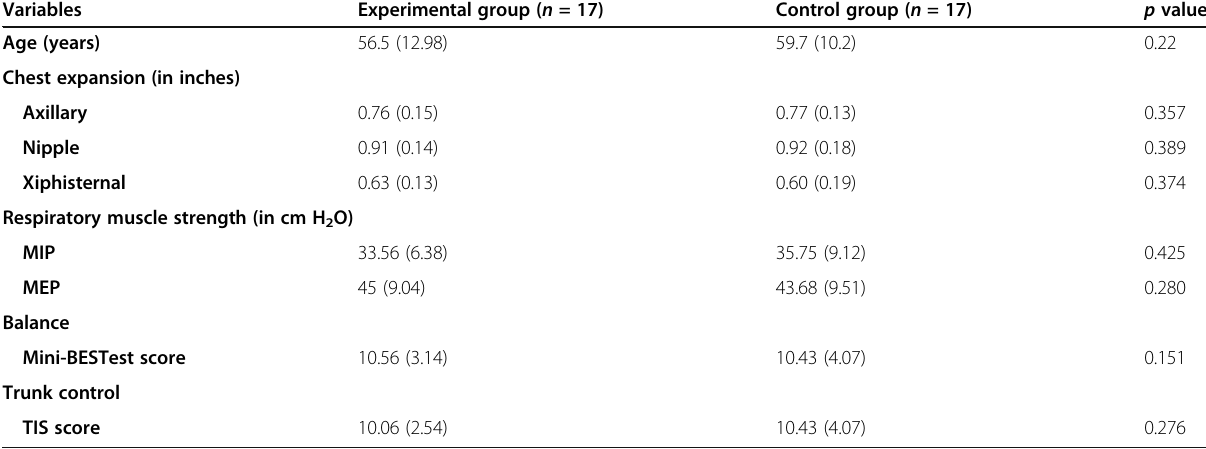
Table 1 Baseline characteristics of participants allocated to the experimental and control group Variables